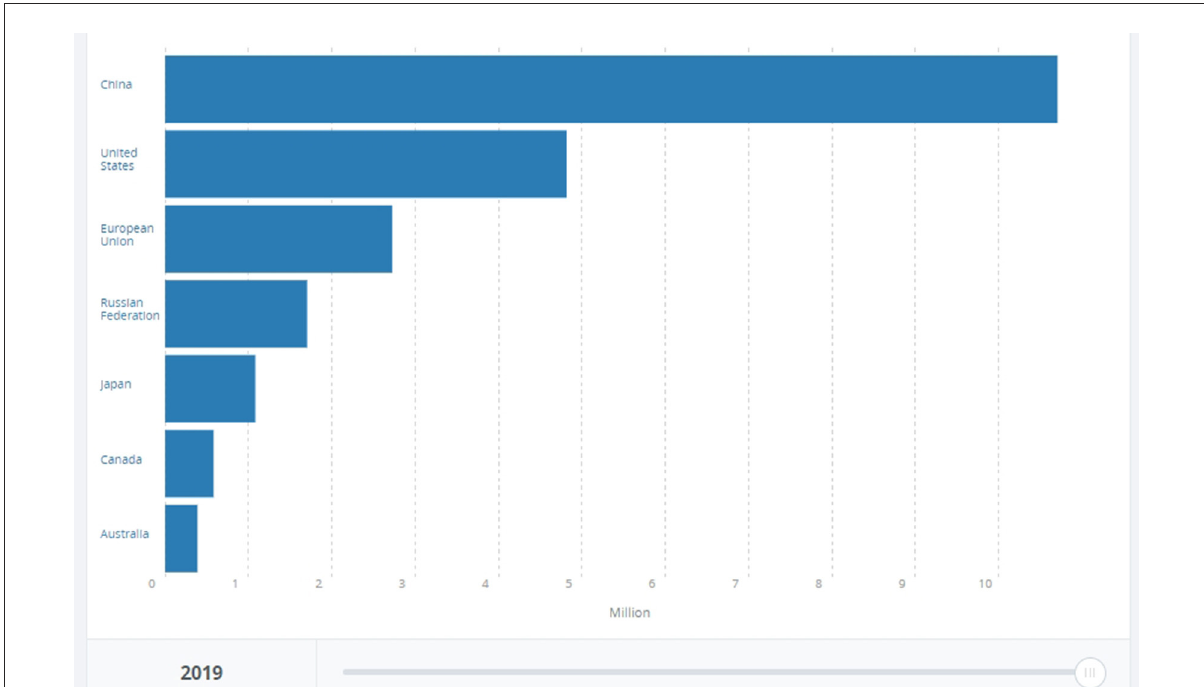
FIGURE1 Share of CO2 emissions of China, the United States, EU28, Russian Federation, Japan, Canada, and Australia. Year: 2019. Data and graphic from the World Bank, at https://data.worldbank.org/indicator/EN.ATM.CO2E.KT?contextual=default&end=2019&locations=CN-US-EU-RU-JP-AU- CA&start=2019&view=bar (accessed August 9, 2022).